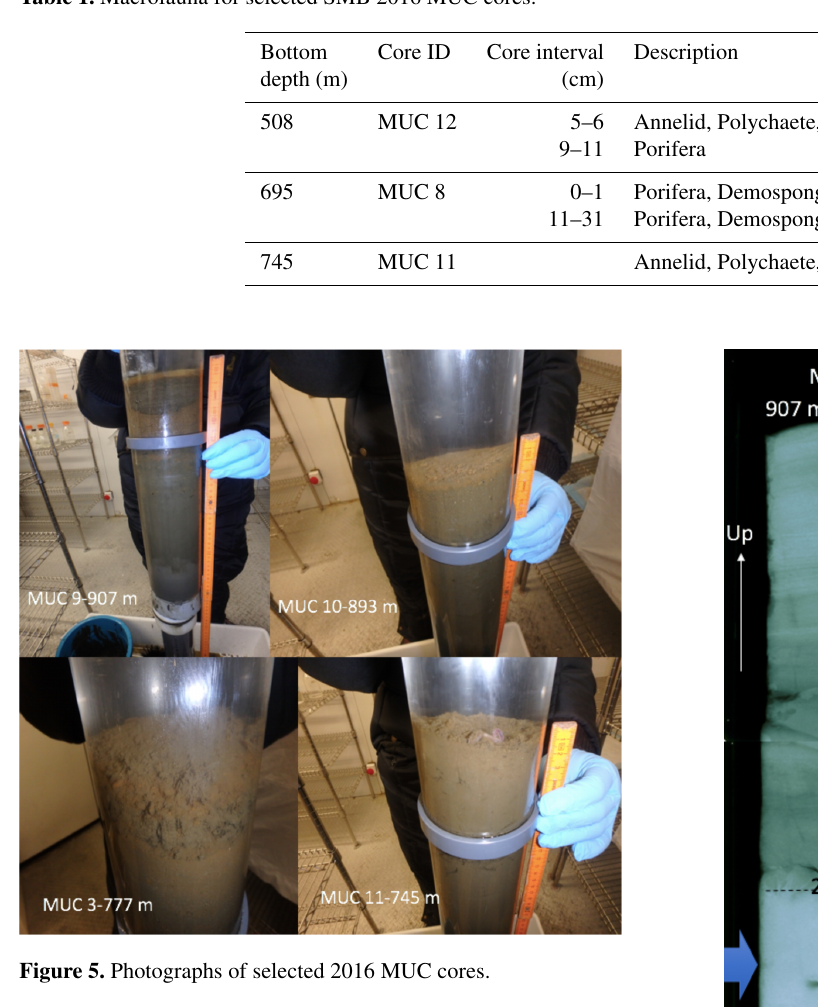
neous. MUC 11 showed a living polychaete worm present at the sediment–water interface.